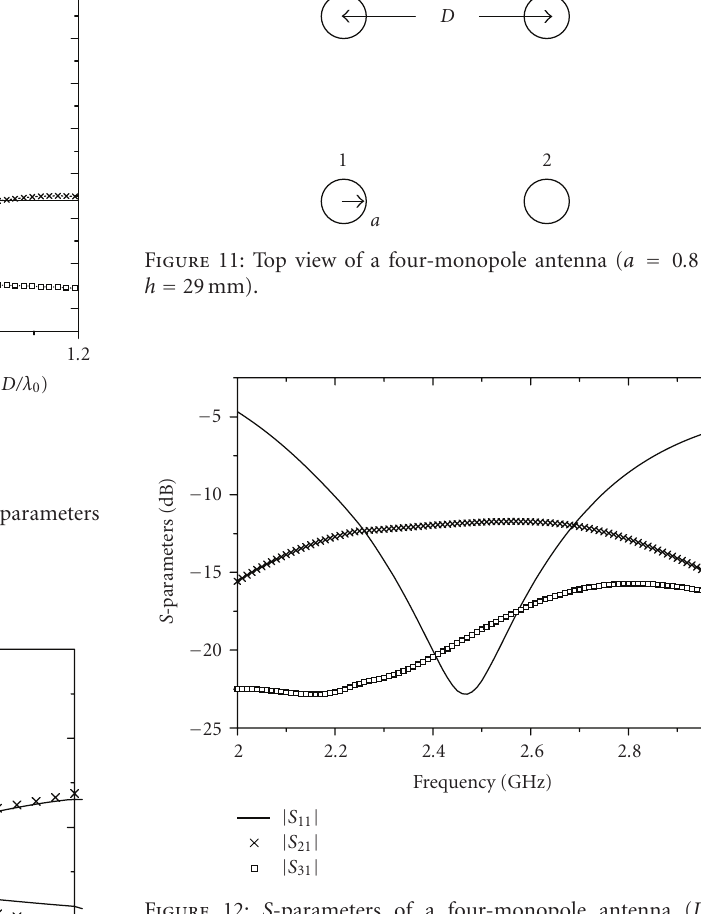
Figure 12: S -parameters of a four-monopole antenna ( D = 61 .